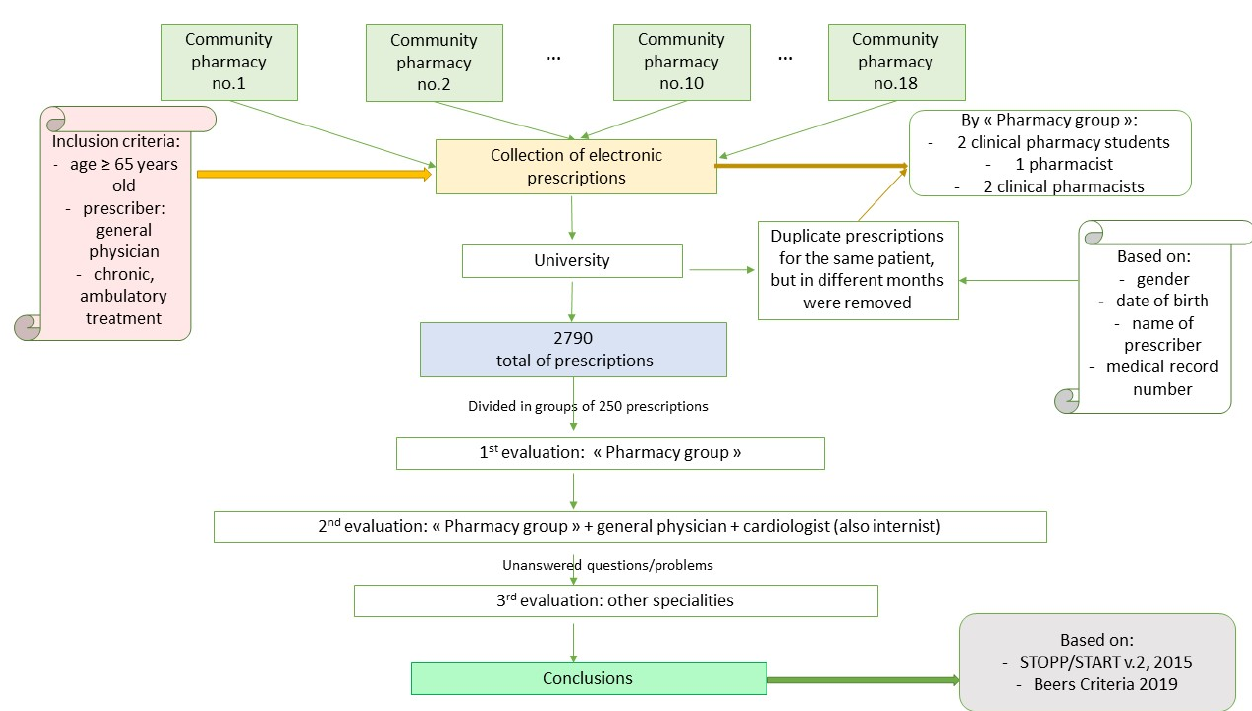
Figure 2. Schematic representation of the study’s methodology.